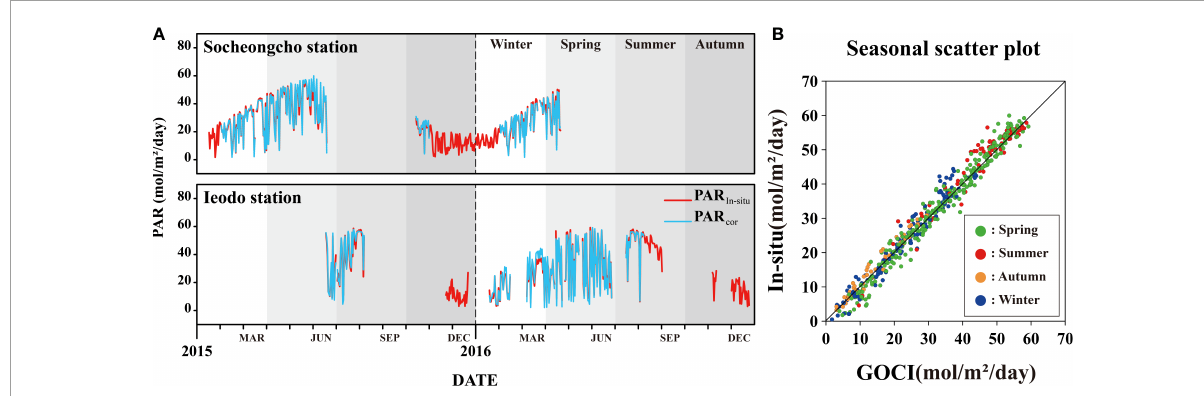
FIGURE 5 Corrected GOCI daily PAR and seasonal scatter plot. (A) Time series of corrected GOCI daily PAR and in situ daily PAR in 2015 and 2016. Blue and red lines indicate corrected GOCI daily PAR (PAR